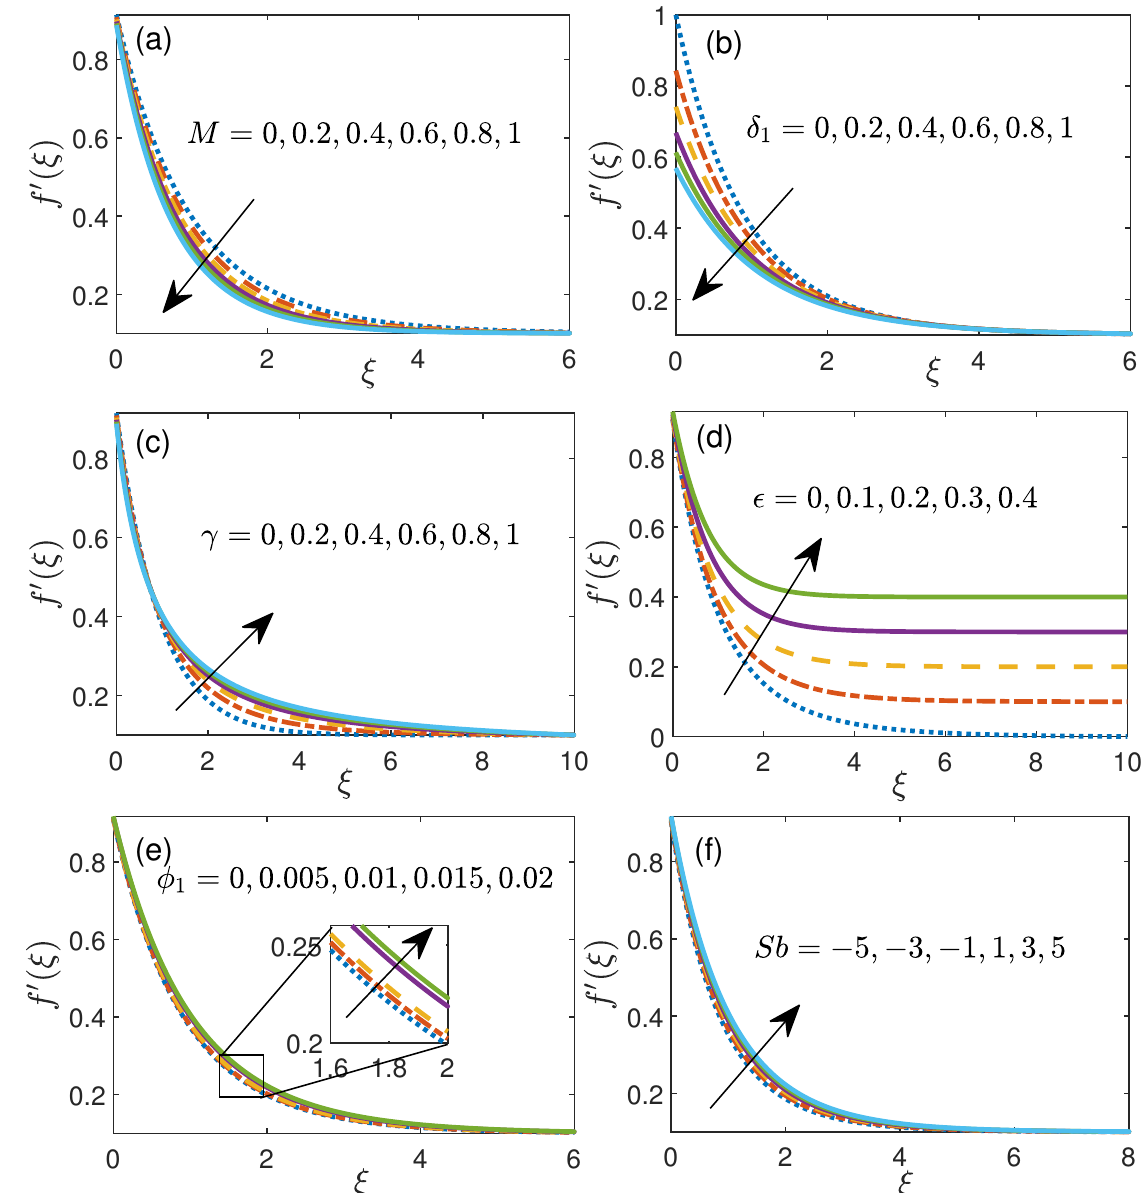
Figure 3. Velocity profile for ( a ) magnetic parameter M , ( b ) velocity slip parameter δ 1 , ( c ) curvature parameter γ , ( d ) free stream velocity (cid:101) , ( e ) initial volume fraction φ 1 and ( f ) Stefan blowing Sb